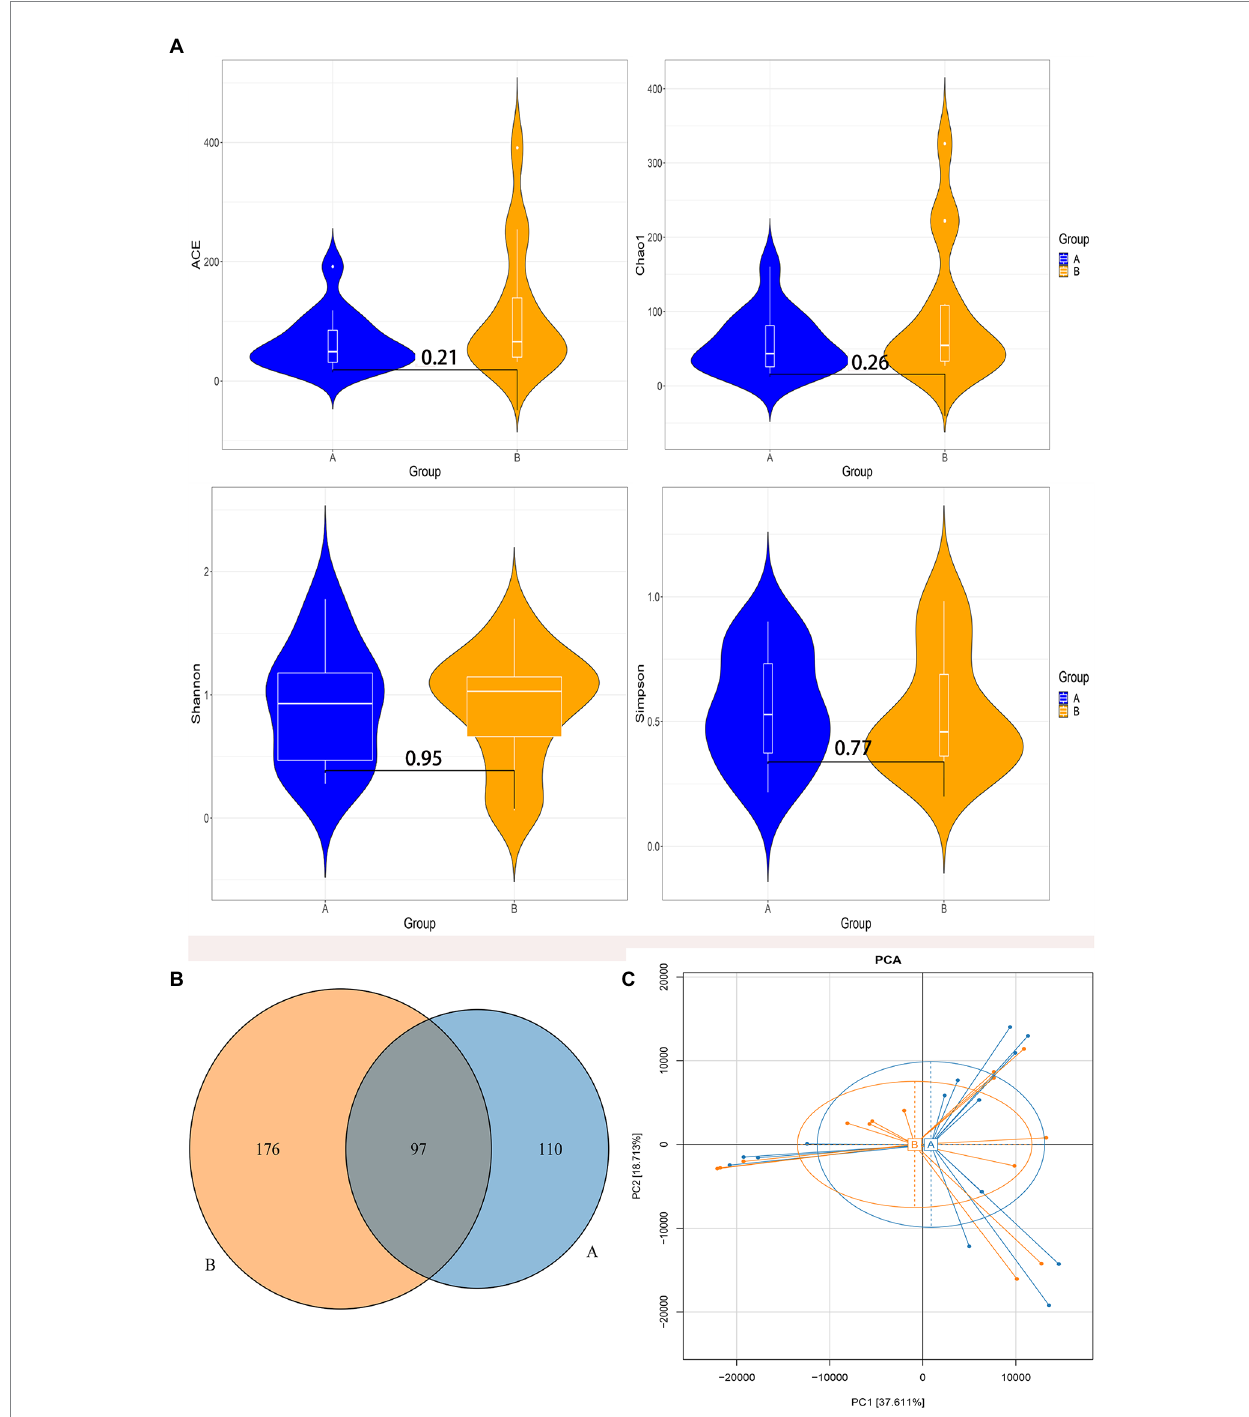
FIGURE 2 Diversity analysis of gut microbiota. (A) The comparison of the Alpha diversity index between the two groups. (B) Venn diagram of operational taxonomic units (OTUs) among the two groups. (C) Principal component analysis based on OTUs abundance table. Group A: the control group; Group B: the case